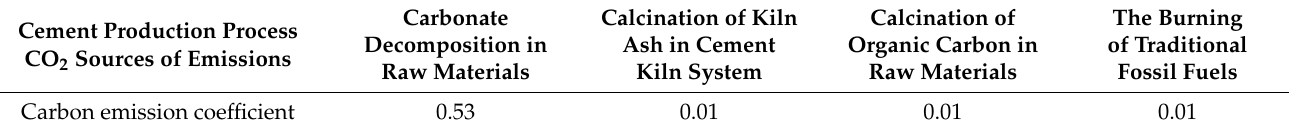
Table 2. CO 2 emission coefficient in cement production process (IPCC, 2006)